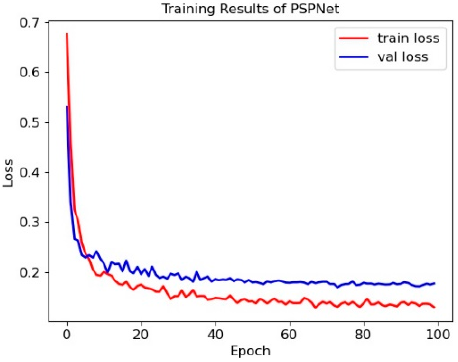
Figure 6. Training results of the PSPNet.